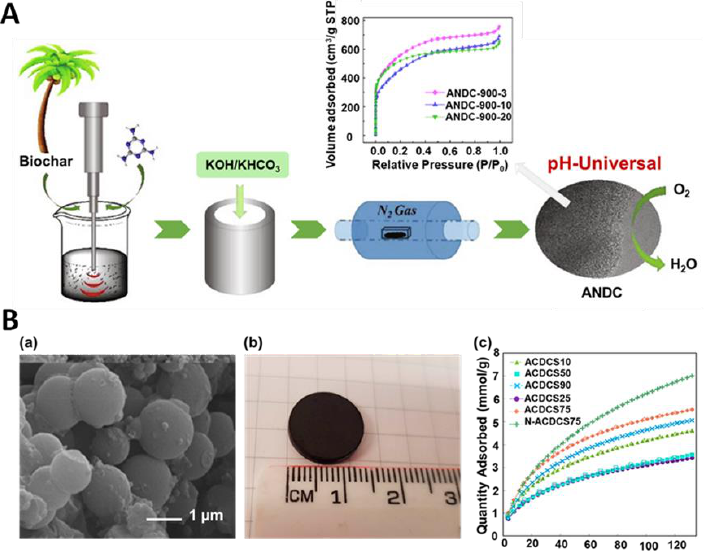
Figure 7. ( A ) Schematic illustration of a synthesis of biomass-derived activated carbons and nitrogen isotherms of the samples sonicated for 3, 10 and 20 min (ANDC-900-3, ANDC-900-10 and ANDC- 900-20, respectively) [78]. Reproduced with permission from ref. [78]. Copyright 2020, Elsevier B.V. ( B ) ( a ) SEM images and ( b ) photograph of an activated carbon disc (ACD) prepared with 75% of carbon spheres. ( c ) CO 2 adsorption at 0 °C on ACDs prepared with different content of carbon spheres [80]. Reproduced with permission from ref. [80]. Copyright 2019, American Chemical Soci- ety.